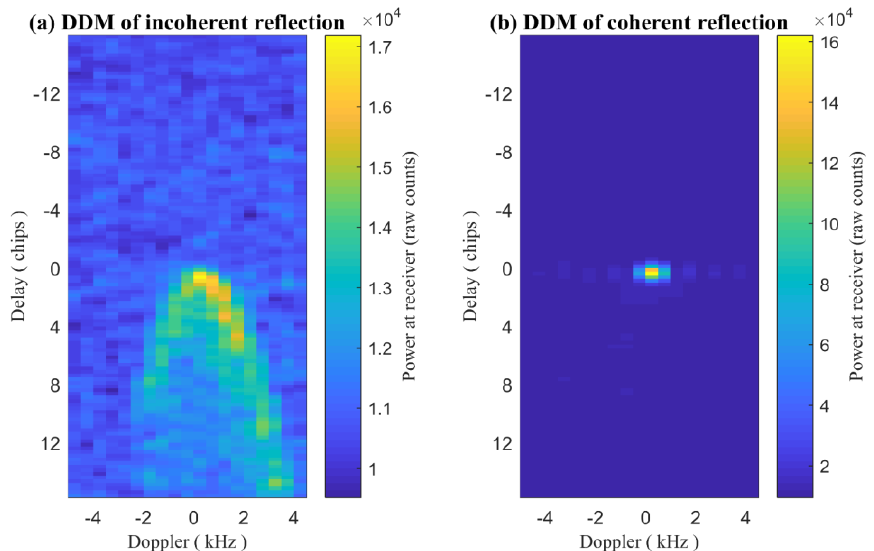
Figure 1. Typical TDS-1 Delay-Doppler Maps (DDMs) of ( a ) incoherent and ( b ) coherent returns. The incoherent and coherent DDMs are observed over open water (OW) (8.05 ◦ E, 79.53 ◦ N) and first-year ice (FYI) (0.93 ◦ W, 79.99 ◦ N), respectively, on 26 November